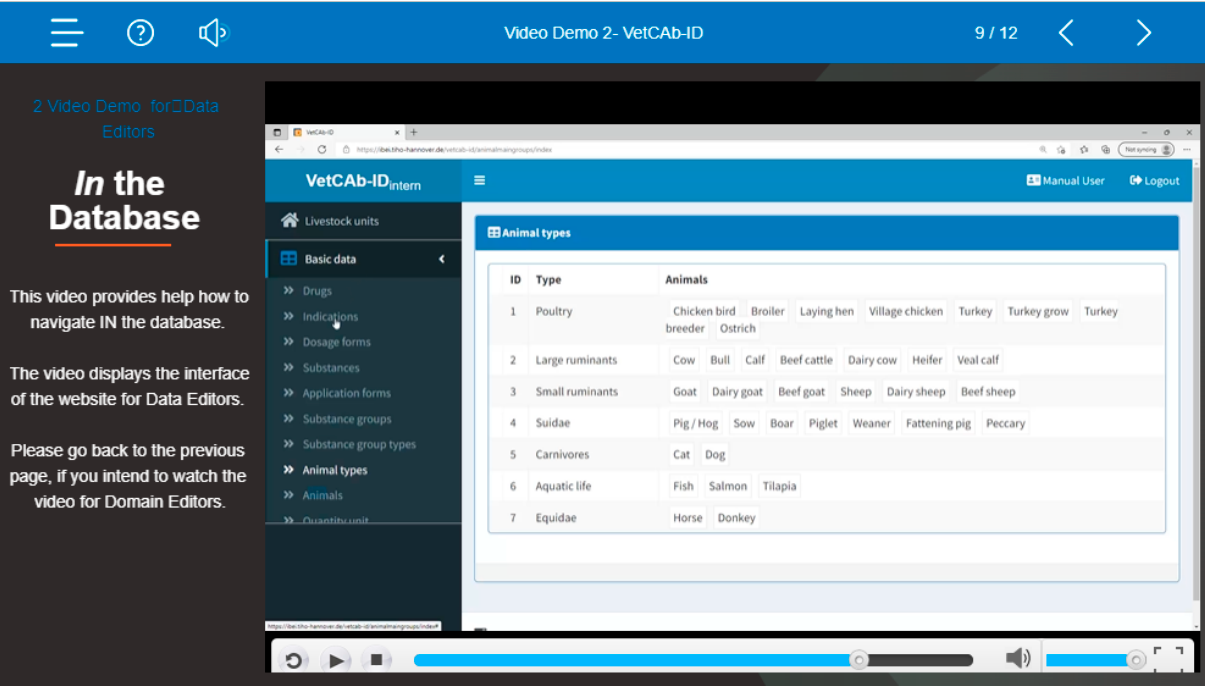
Figure 2. Screenshot from the second learning video for the VetCAb-ID database.